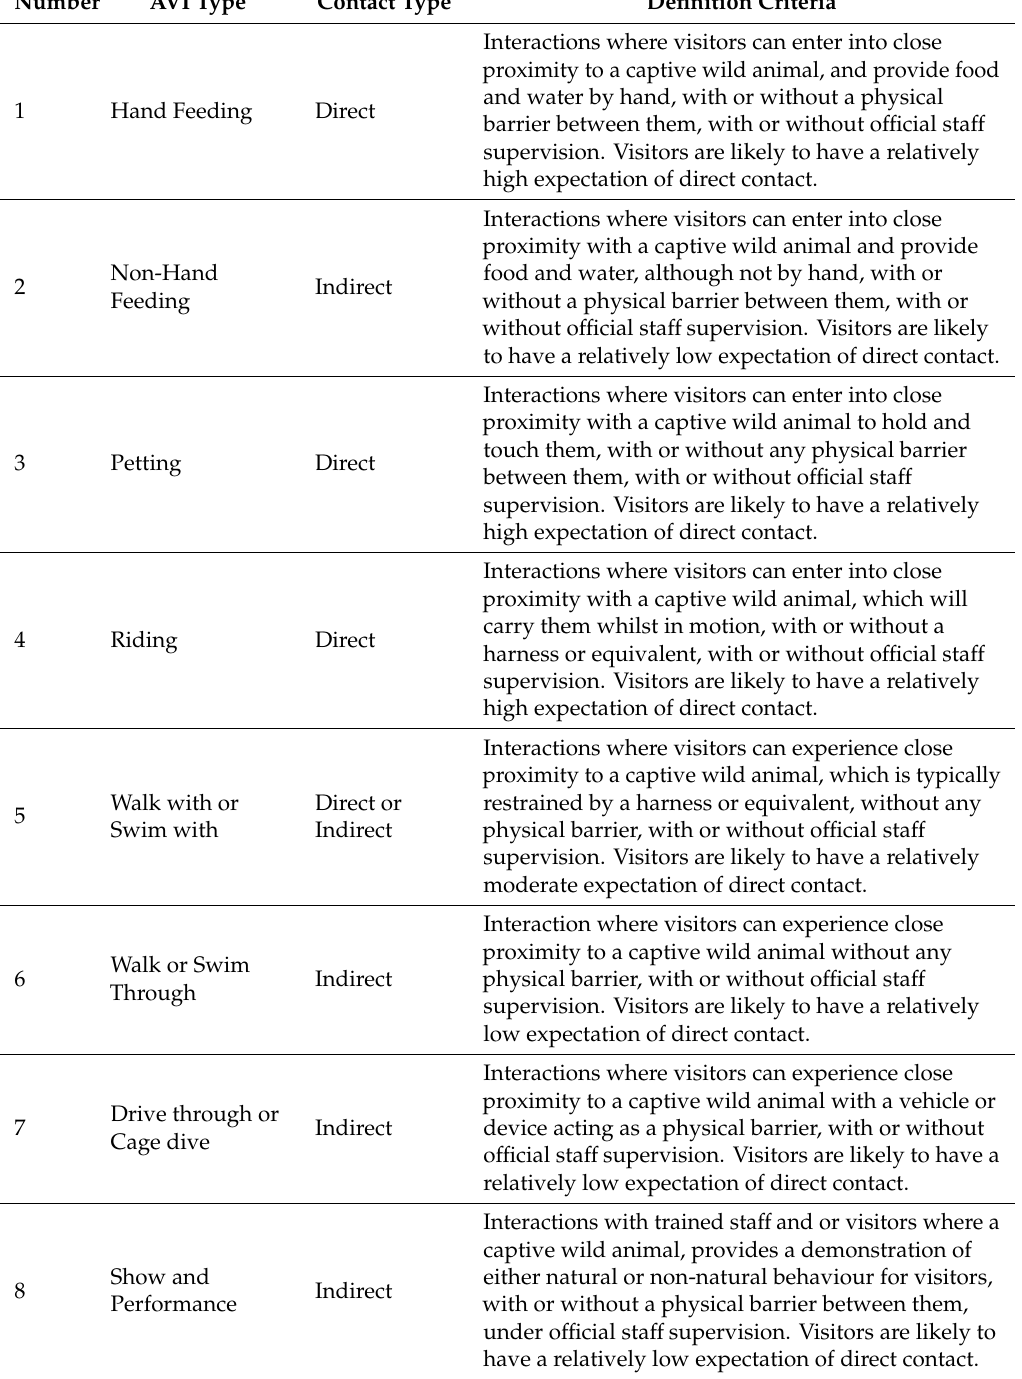
Table 1. Animal–visitor interaction (AVI) definition criteria used during this